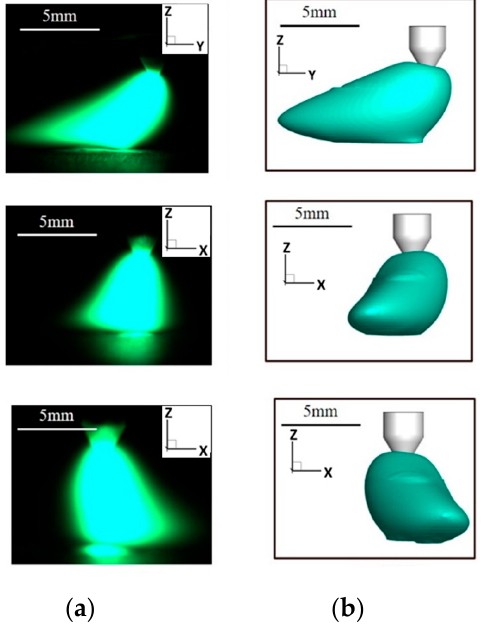
Figure 25. Arc temperature distribution in the simulated and experimental results.